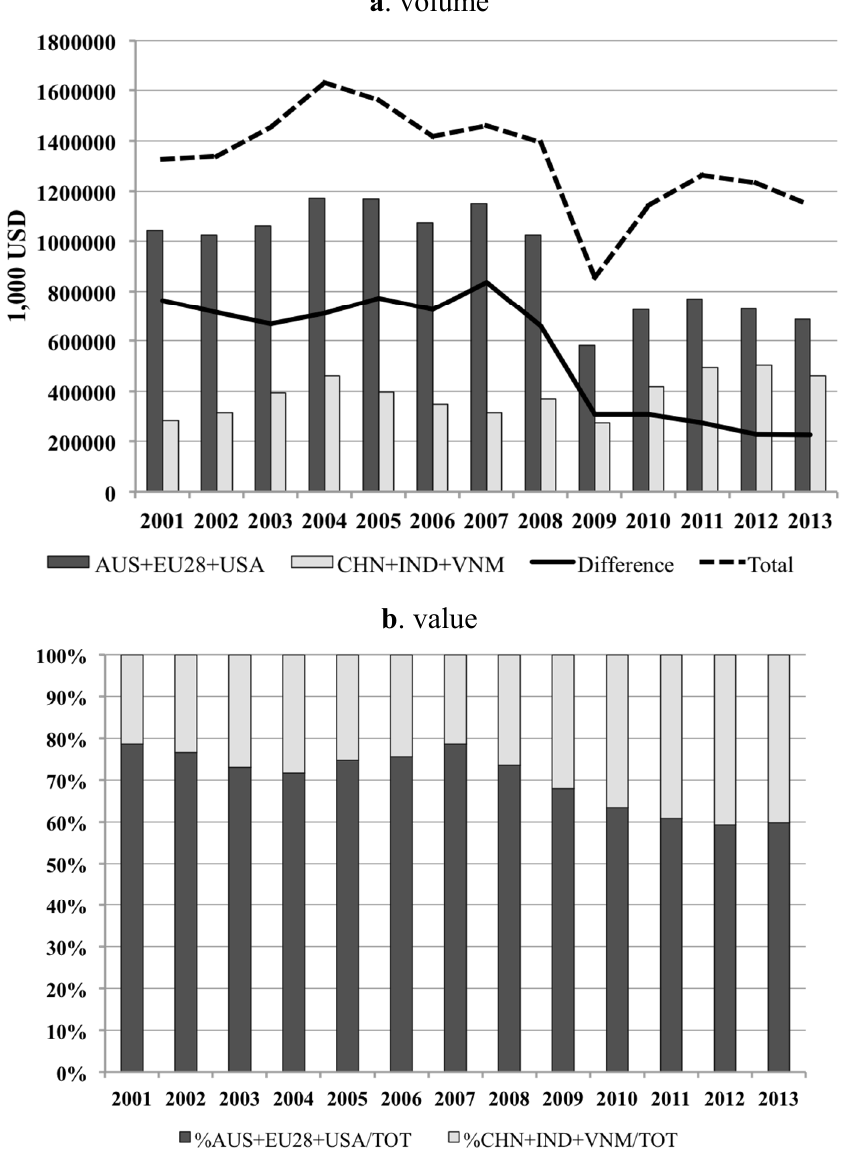
Figure B4. ( a ) Tropical timber product imports by groups of selected countries from VPA countries, in value; and ( b ) % incidence of selected countries on total imports (2001–2013). AUS = Australia; CHN = China; EU-28 = European Union; IND = India; USA = United States of America; VNM = Vietnam. Difference means difference between (AUS + EU-28 + USA) and (CHN + IND + VNM). Source: own elaboration from